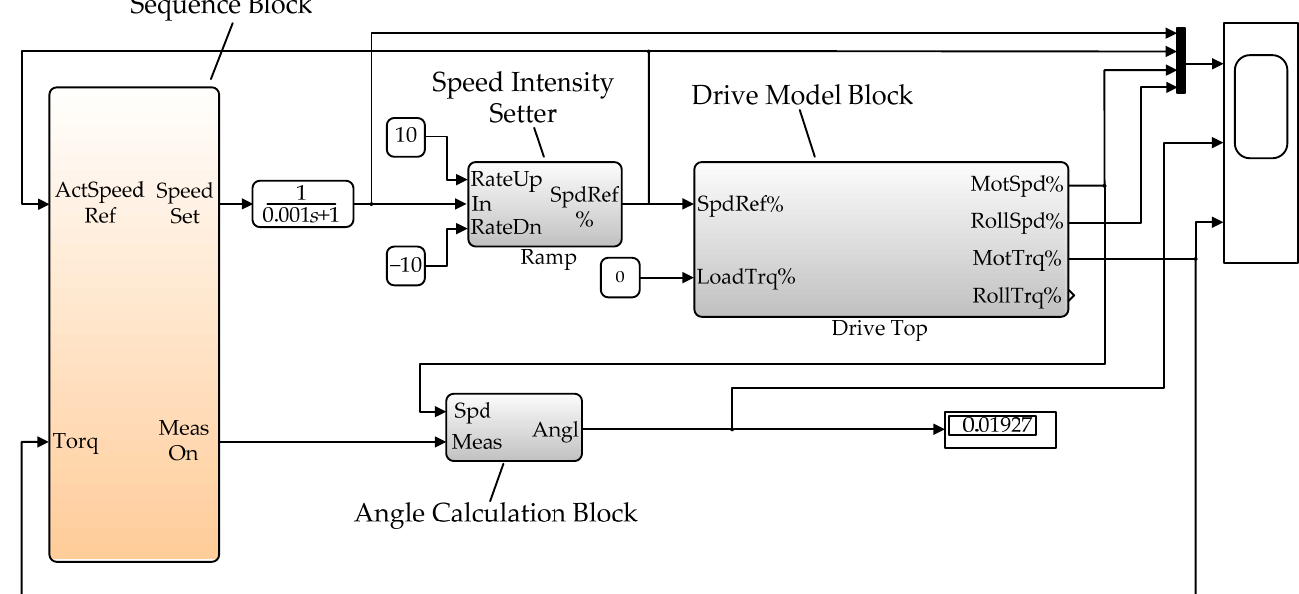
Figure 7. Diagram of the simulation model implementing the angular gap calculation algorithm.